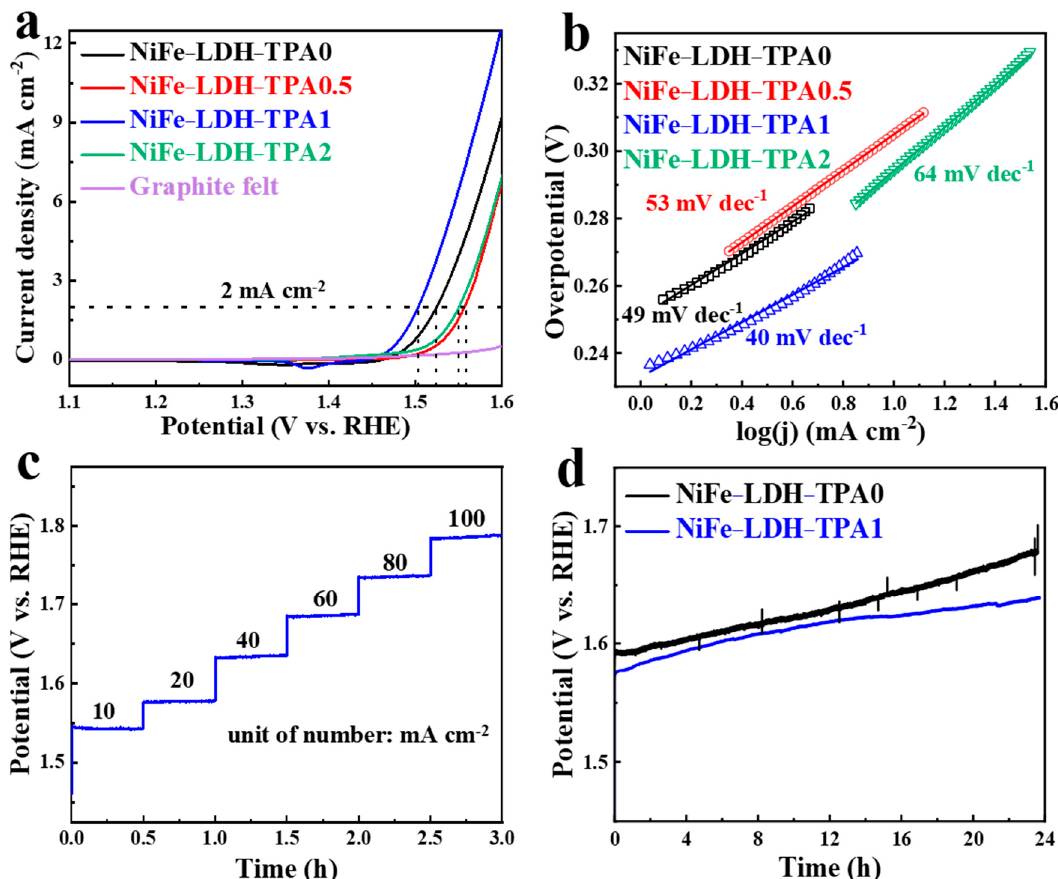
Figure 6. Electrochemical catalytic performance test. ( a ) Linear sweep voltammetry (LSV) curves and ( b ) Tafel slopes of NiFe-LDH-TPA0, NiFe-LDH-TPA0.5, NiFe-LDH-TPA1, NiFe-LDH-TPA2, and graphite felt in 1.0 M KOH. ( c ) Multi-current chronopotentiometric process of NiFe-LDH-TPA1 in 1.0 M KOH. The current density started at 10 mA cm − 2 and finished at 100 mA cm − 2 , and each step lasted for 30 min in 1 M KOH. ( d ) Extended chronopotentiometric curves of NiFe-LDH-TPA1 and NiFe-LDH-TPA0 at 20 mA cm − 2 current density for 24 h of electrolysis in 1.0 M KOH.